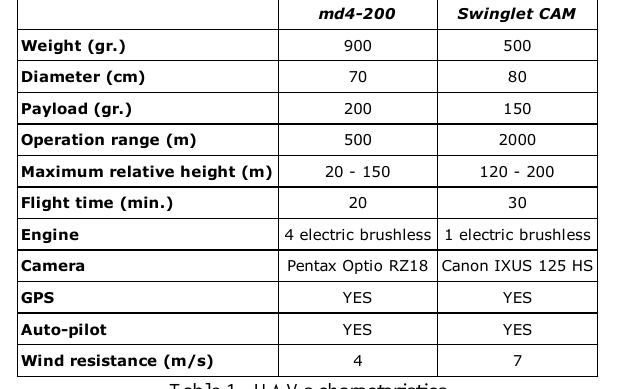
Figure 1. The microdrone md4-200